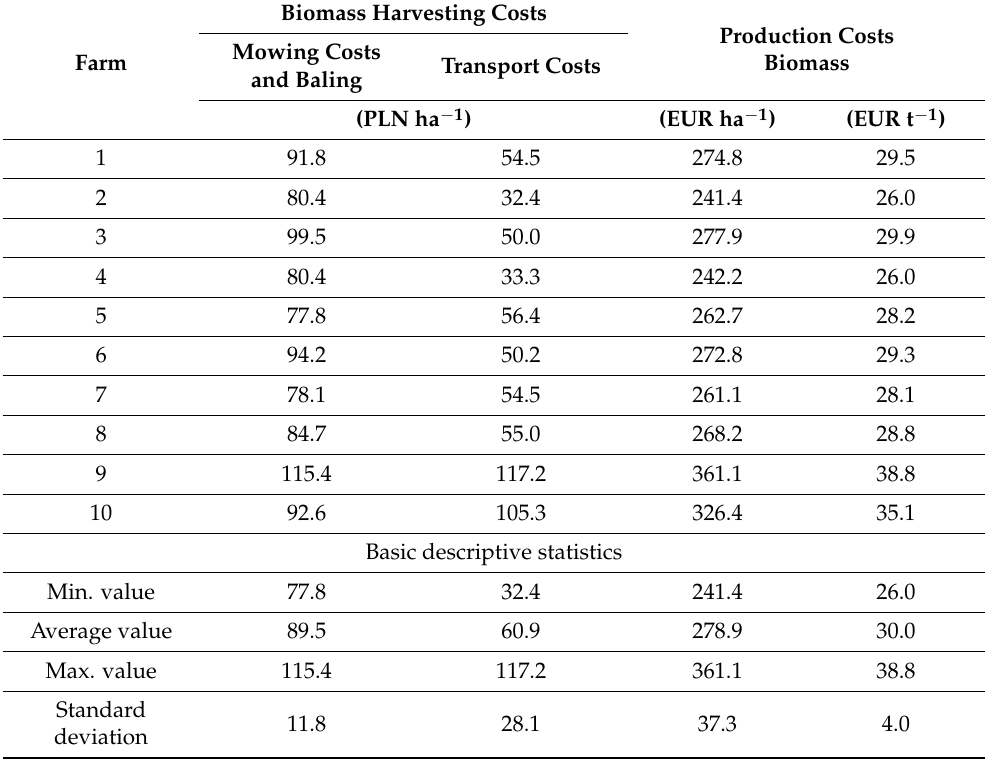
Table 8. Costs of production of biomass from Sida hermaphrodita in the investigated agricultural holdings.